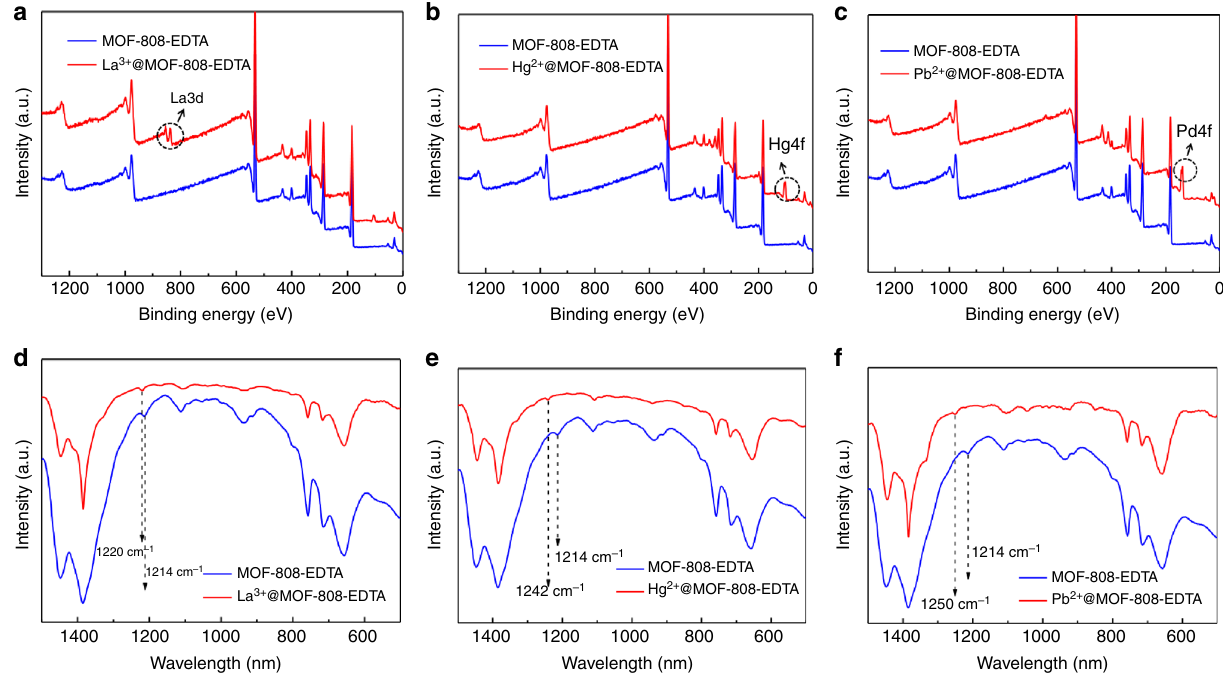
Fig. 4 Characterization of MOF-808-EDTA before and after metal ion loading. a – c Wide-scan XPS spectra and d – f FT-IR spectra of MOF-808-EDTA before and after La 3+ , Hg 2+ , and Pb 2+